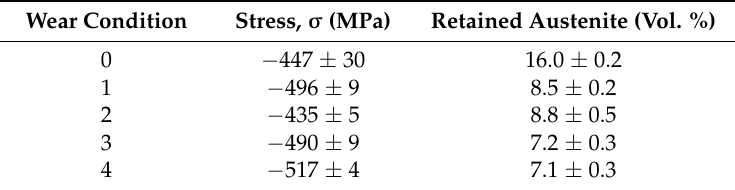
Figure 11. Residual stresses and amount of retained austenite, measured by x-ray diffraction analysis for the different wear conditions.